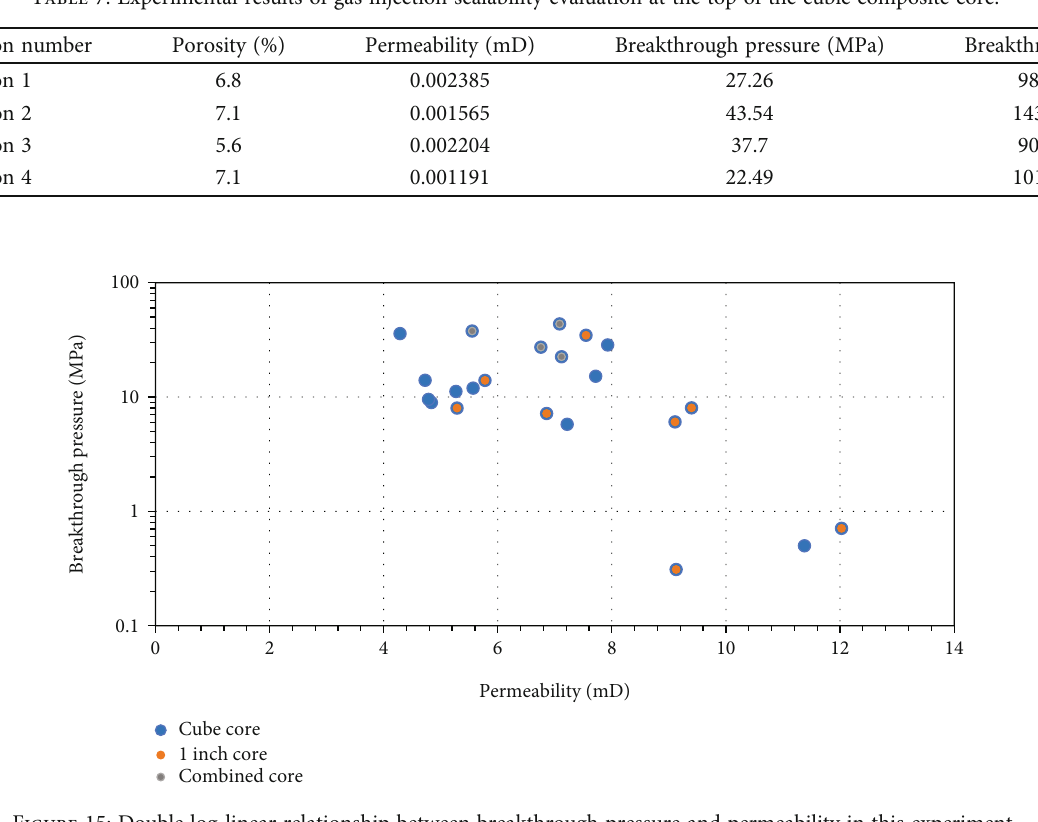
Figure 15: Double log-linear relationship between breakthrough pressure and permeability in this